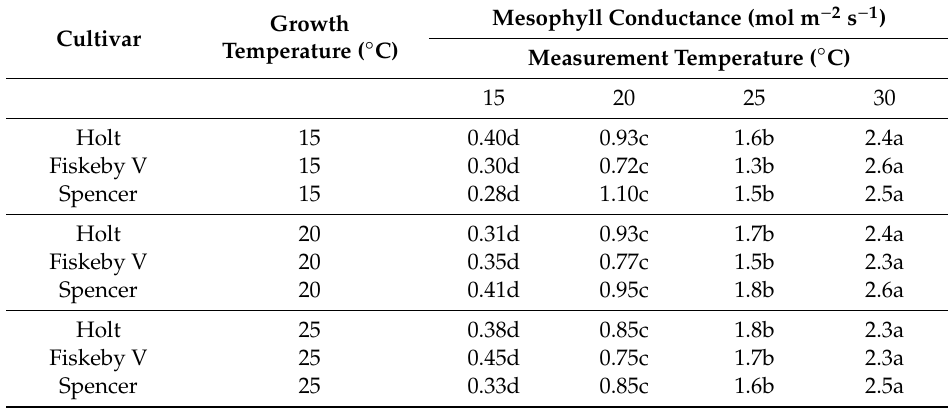
Table 1. Mesophyll conductance to CO 2 movement from the intercellular airspace to the site of fixation (g m ) in three soybean cultivars grown at three temperatures, and measured over the range of 15 to 30 °C. Values are means for 3 or 4 leaves. Values followed by different letters are different at P = 0.05, using analysis of variance on log transformed data in order make variances homogeneous.